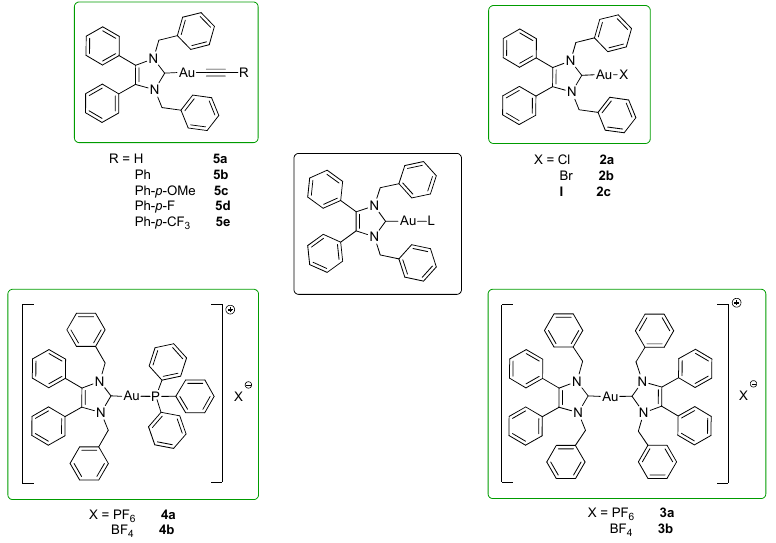
Figure 2. NHC* ‐ gold(I) complexes studied in this report. Figure 2. NHC*-gold(I) complexes studied in this